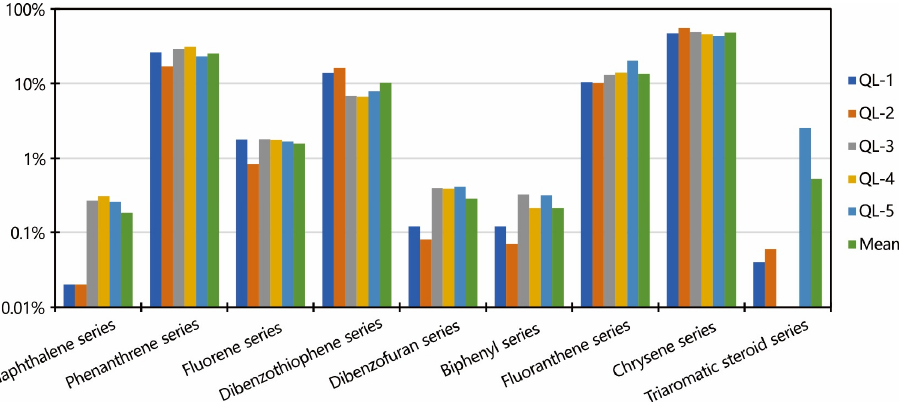
Figure 9. Composition of aromatic compounds in bitumen samples from Qinglong paleo-oil reser- voir.